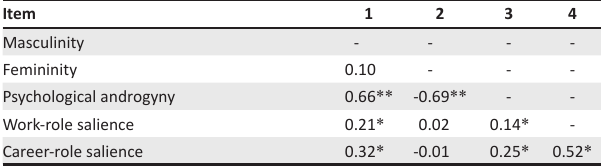
TABLE 1: Correlation coefficients for the latent